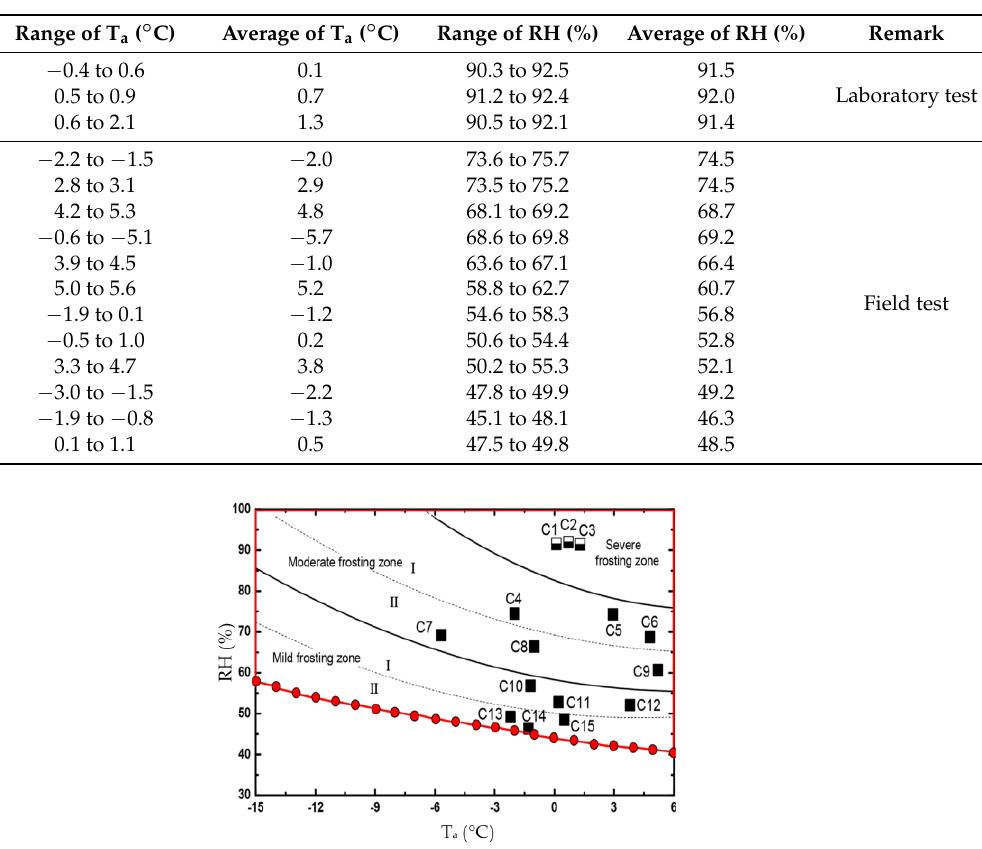
Table 2. Operation conditions of all test cases [63].